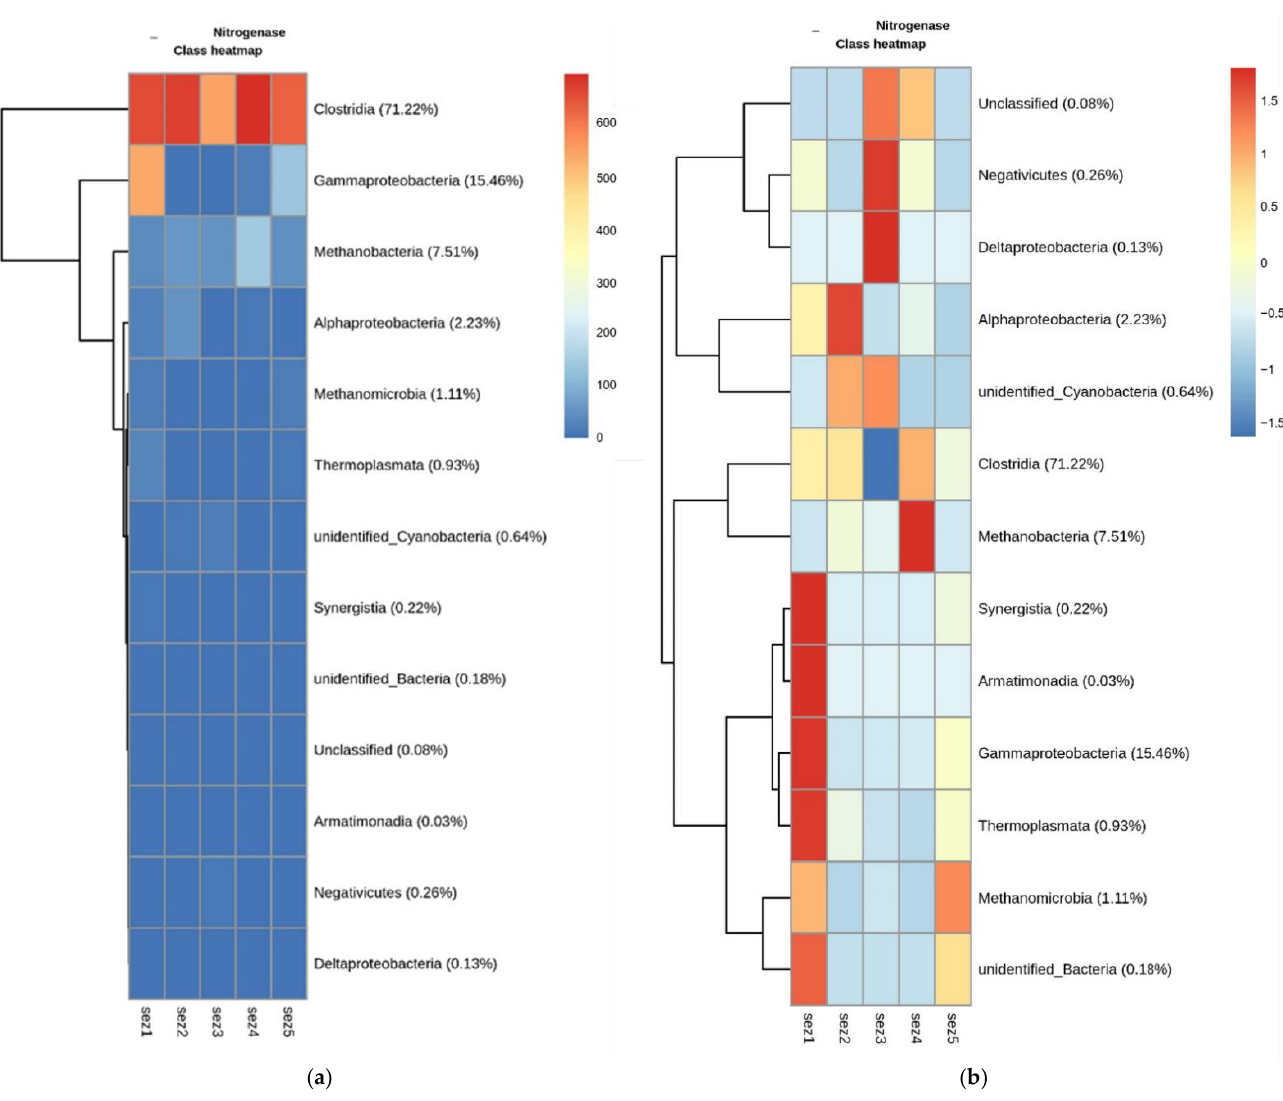
Figure A9. Functional heatmaps of nitrogenase hydrogenase: ( a ) absolute counts and ( b ) autoscaled counts, aggregated at the class level.